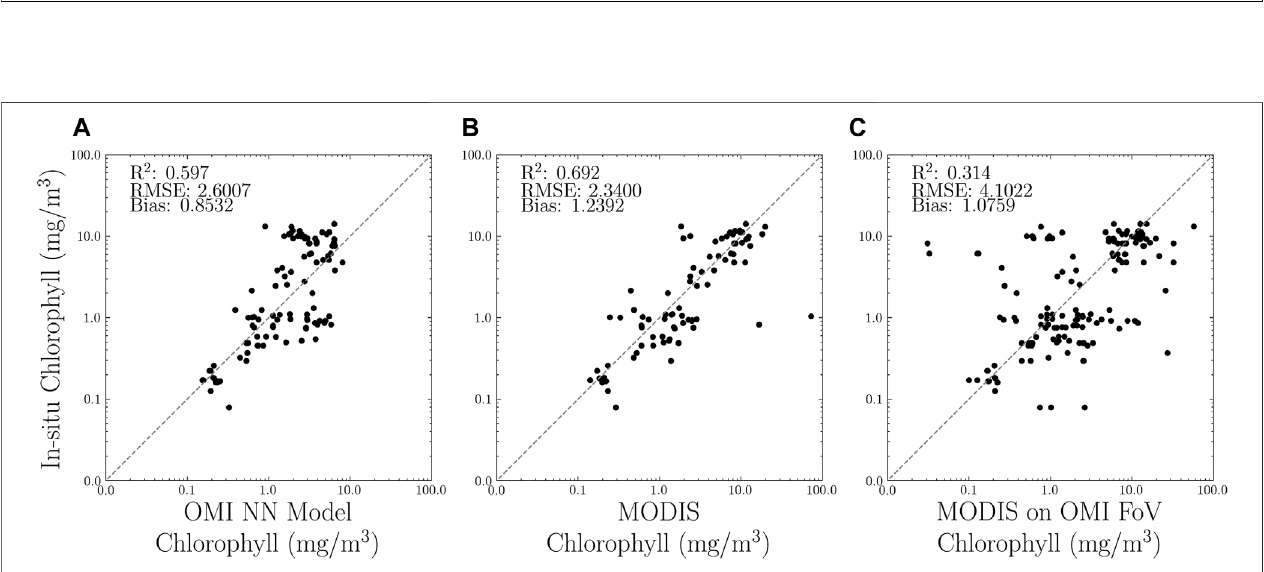
FIGURE14| Retrievalsofchlorophyll compared with insitu measurements. (A) istheOMI machinelearning – basedchlorophyll, (B) istheMODIS-Aquachlorophyll at the native resolution, and (C) is the MODIS-Aqua chlorophyll retrieval co-located to the OMI FoV. There are 163 co-located points in the comparison.